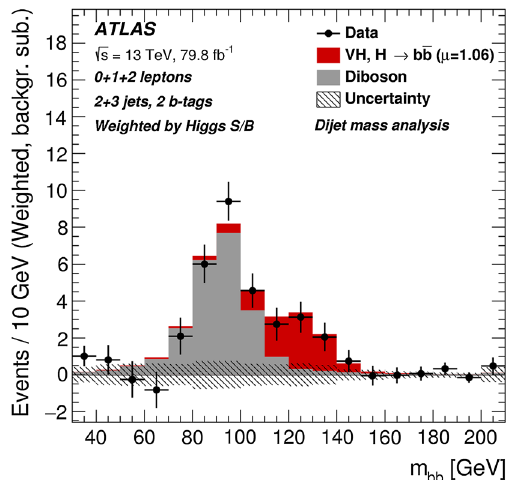
Fig. 2 Weighted bottom anti-bottom quark invariant mass data from ATLASfor79 . 8fb − 1 [26].Theplotincludesallfinalstateswith0,1and 2 leptons and it compares the data yield with 1 . 06 × the SM expectation of H → b ¯ b , and the SM expectation of Z → b ¯ b